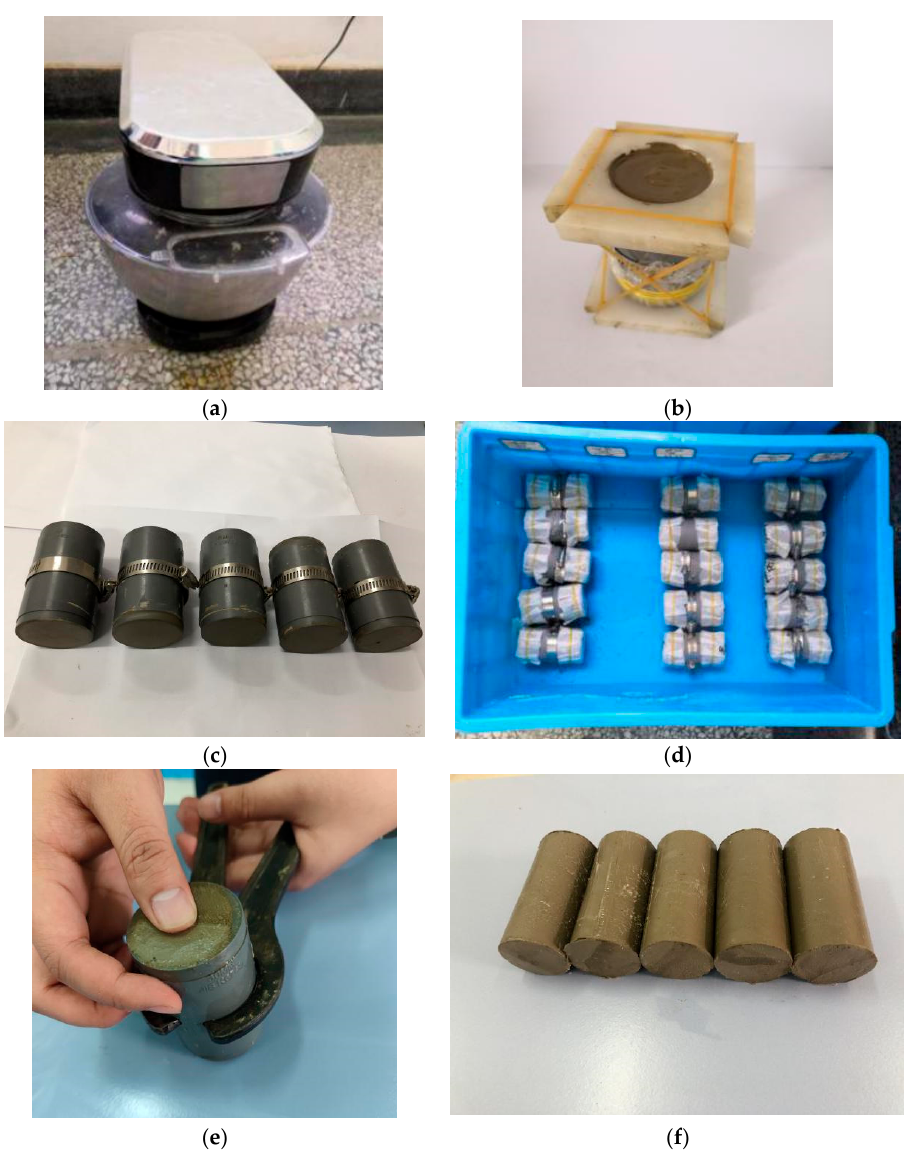
Figure 6. ( a – f ) Main processes of sample preparation